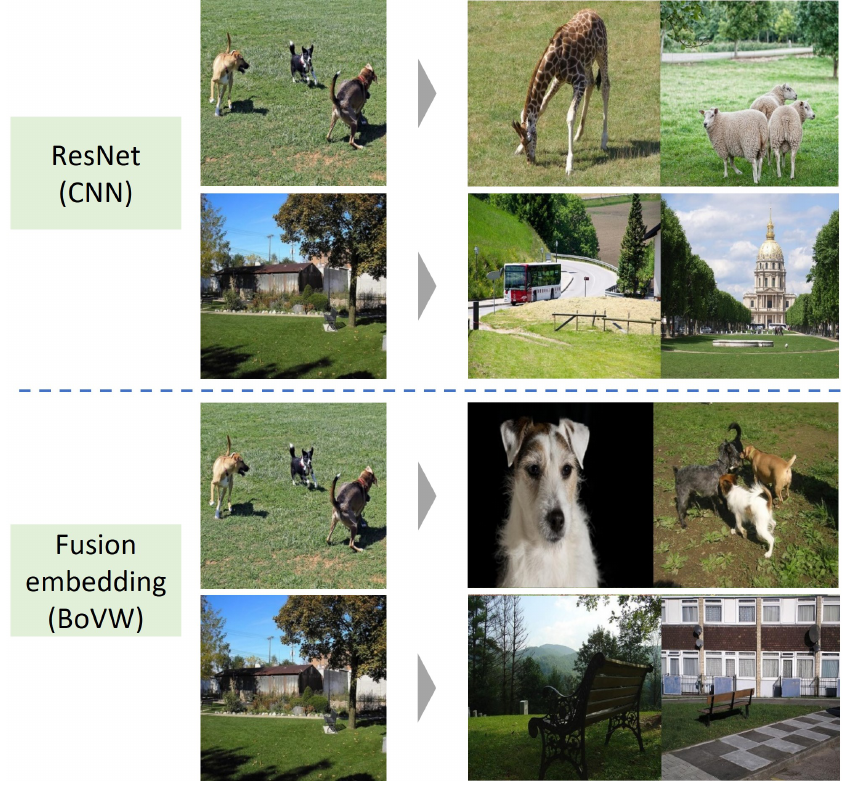
Figure 11. The results of CNN and fusion image embedding. The image on the left is the query image and the image on the right side of the arrow is the retrieved